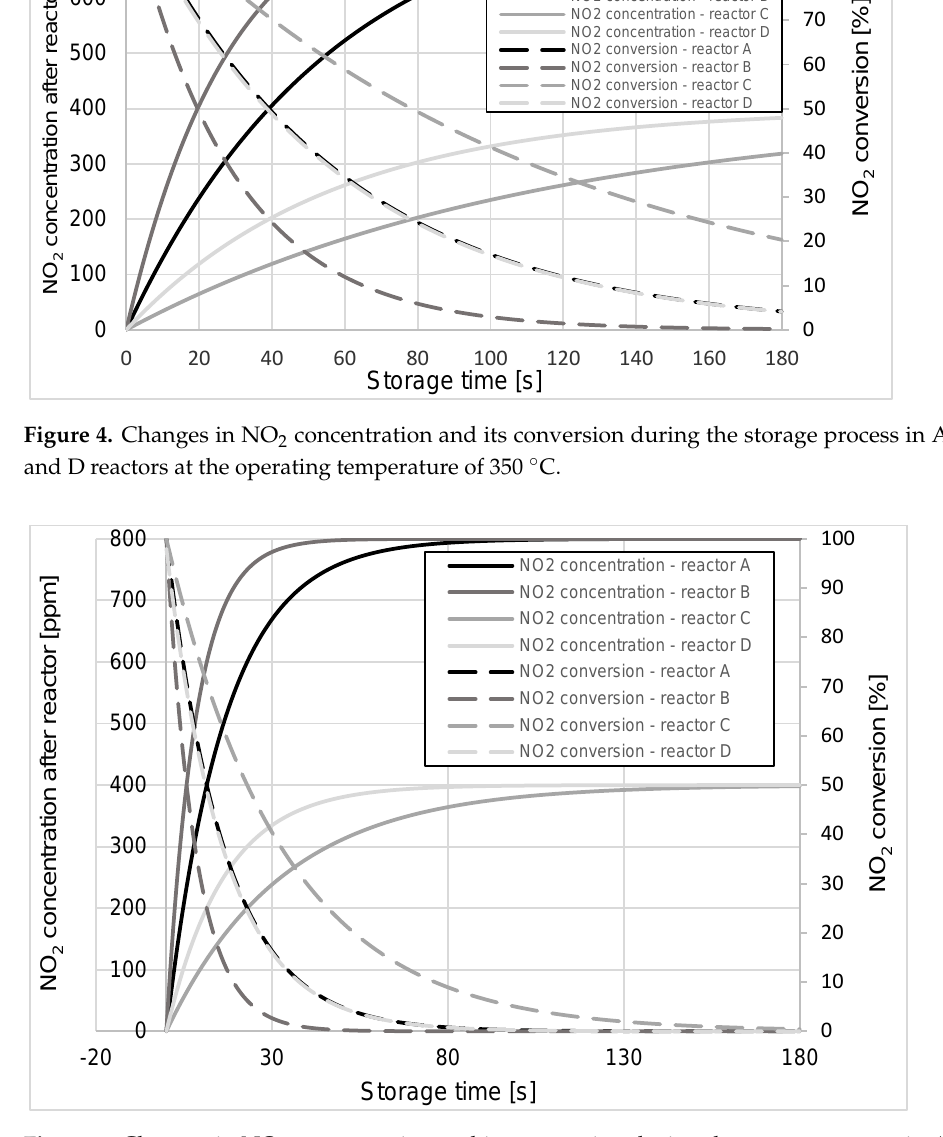
Figure 5. Changes in NO 2 concentration and its conversion during the storage process in A, B, C, and D reactors at the operating temperature of 600 °C .